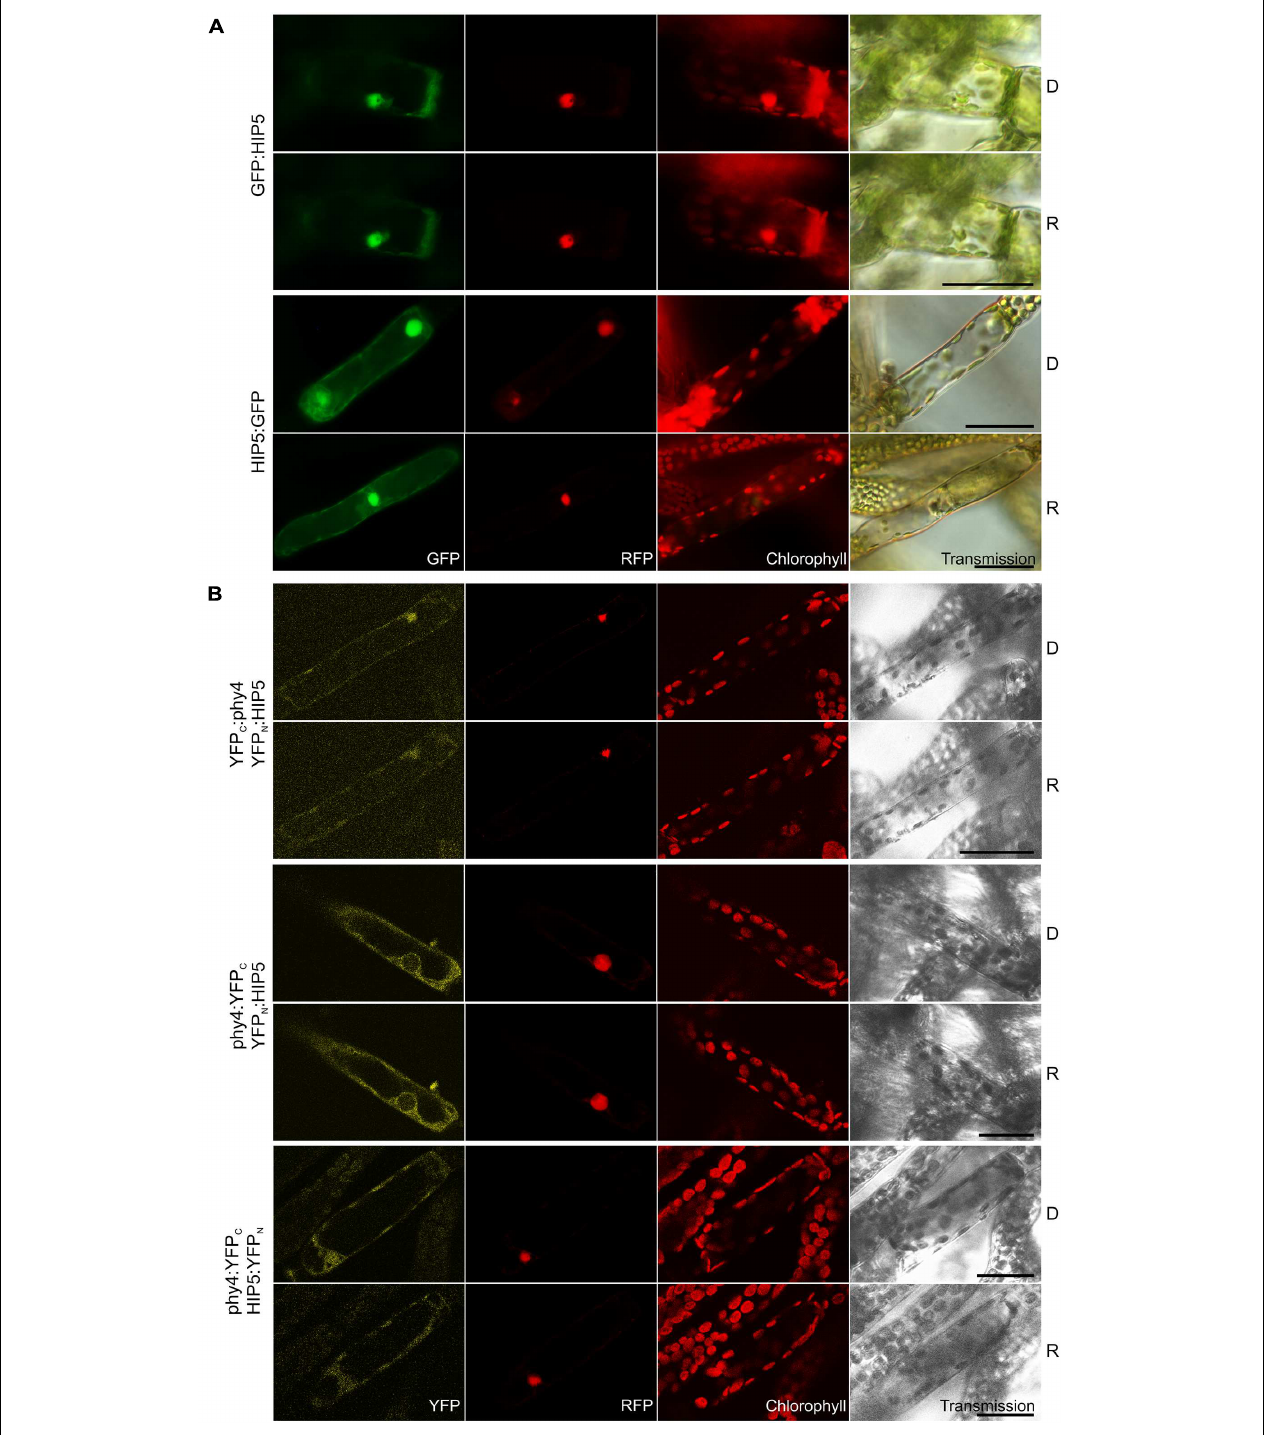
FIGURE 4 | HIP5 (Pp3c7_3040V1.1) intracellular localization (A) and split-YFP-studies of HIP5–phy4 interaction (B) each without (D) and with red pre-treatment (R) using fluorescence- and confocal microscopy, respectively. Overall figure structure is analogous to Figure 1 . (A) GFP:HIP5 (rows 1 and 2) and HIP5:GFP (rows 3 and 4) were distributed in the cytoplasm and in the nucleus (column 1, GFP). (B) Three split-YFP configurations were examined and showed different signal patterns/strengths (column 1, YFP): YFP C :phy4–YFP N :HIP5 (rows 1 and 2; maybe nucleo-cytoplasmic distribution), phy4:YFP C –YFP N :HIP5 (rows 3 and 4; cytoplasmic distribution) and phy4:YFP C –HIP5:YFP N (rows 5 and 6; nucleo-cytoplasmic distribution). The apparent YFP C :phy4–YFP N :HIP5 signal might also represent RFP bleed-through in the YFP channel since the signal was very weak. Scale bars 30 µ